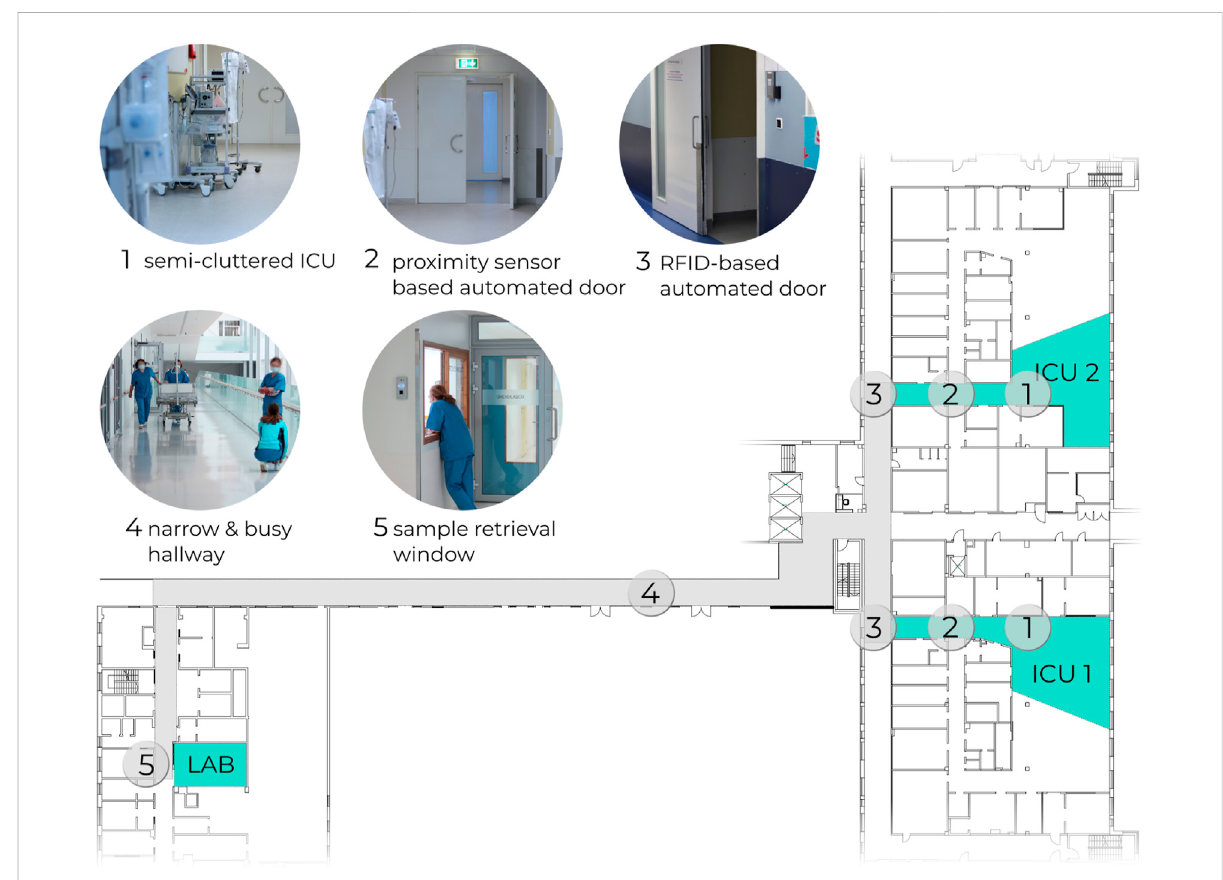
FIGURE 1 Floorplan of the section in Tartu University Hospital, where the object transportation tasks were